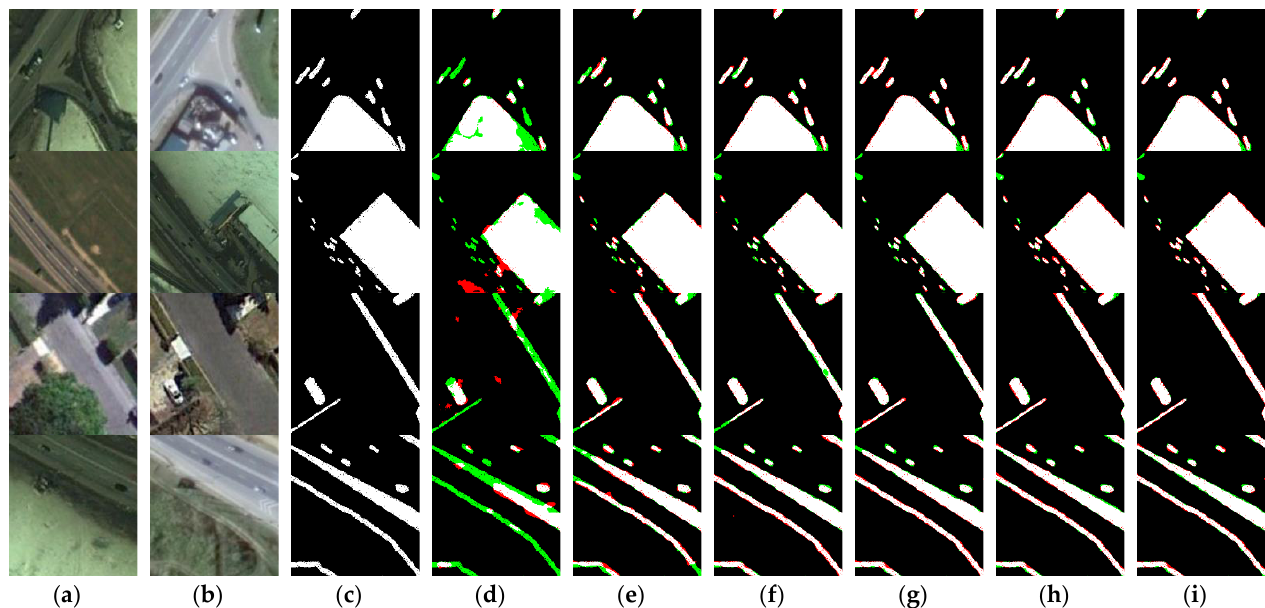
Figure 10. Visual results on CCD dataset: ( a ) Image T1; ( b ) Image T2; ( c ) ground truth; ( d ) FC-Siam-conc; ( e ) U-Net++; ( f ) DASNet; ( g ) STANet; ( h ) SNUNet; ( i ) MCCRNet.